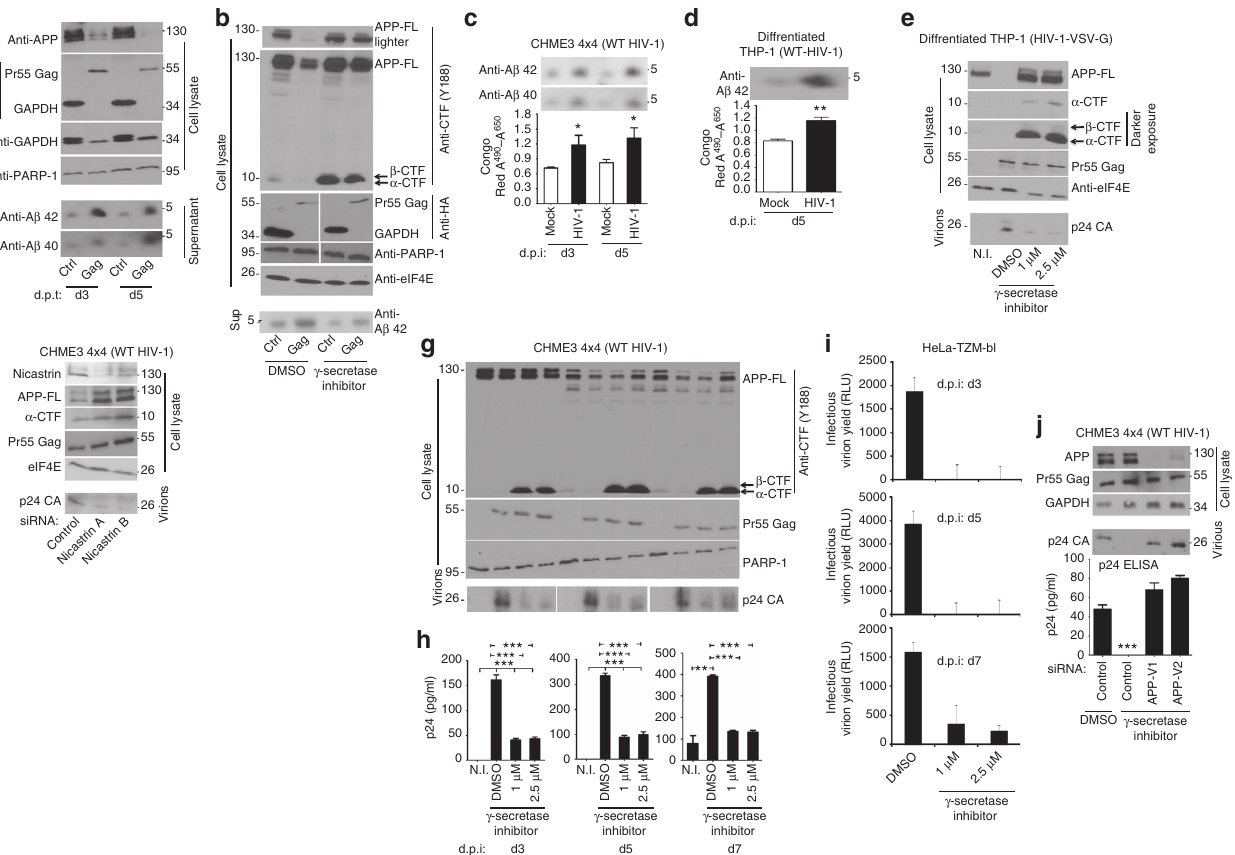
Fig. 5 HIV-1 Gag promotes APP processing into A β isoforms. a Decreased APP levels in Gag-expressing 293T cells correlates with increased secretion of A β 40 and A β 42 compared to GAPDH (Ctrl) at days 3 (d3) and 5 (d5) post-transfection (d.p.t). b Gag-induced processing of APP and A β 42 accumulation in transfected 293T cells is blocked by γ -secretase inhibitor treatment. Full-length APP: APP-FL, C-terminal fragments: α -CTF and β -CTF. c , d A β 40 and/or A β 42 secretion from CHME3 4 × 4 cells c or differentiated THP-1 cells d is enhanced upon infection with WT HIV-1 (pNL4-3 derived), detected by either WB analysis (top panels) or Congo Red staining of amyloid (lower graphs). e Infection of differentiated THP-1 cells with HIV-1 pseudotyped with VSV-G envelope to increase infection ef fi ciency results in production of p24 CA and a reduction in cellular APP levels, and both process are inhibited by γ - secretase inhibitor. f Depletion of Nicastrin suppresses APP processing, as seen by the accumulation of APP and CTFs, and reduces the levels of WT HIV-1 particles in supernatants of infected CHME3 4 × 4 cultures. g , h γ -secretase inhibitor treatment blocks APP processing, as seen by the accumulation of α - CTF and β -CTF, and reduces the levels of WT HIV-1 particles in supernatants of infected CHME3 4 × 4 cultures at d3-d7 d.p.i., detected either by WB using anti-p24 CA antibody ( g ) or ELISA ( h ). i As in g , h , except that infectious virus yield was measured using TZM-bl indicator cells. j siRNA-mediated depletion of APP in CHME3 4 × 4 renders infection with WT HIV-1 insensitive to γ -secretase inhibitors as determined by measurements of p24 CA levels in culture supernatants by either WB analysis or ELISA. The data in c , d (lower panels) as well as h – j (lower panel) represent average of 3 replicates, and are represented as mean +/ − SEM (one-way ANOVA; * P < 0.05, ** P < 0.01, *** P < 0.001). Molecular weight markers (in kDa) are shown either to the right or to the left of WBs